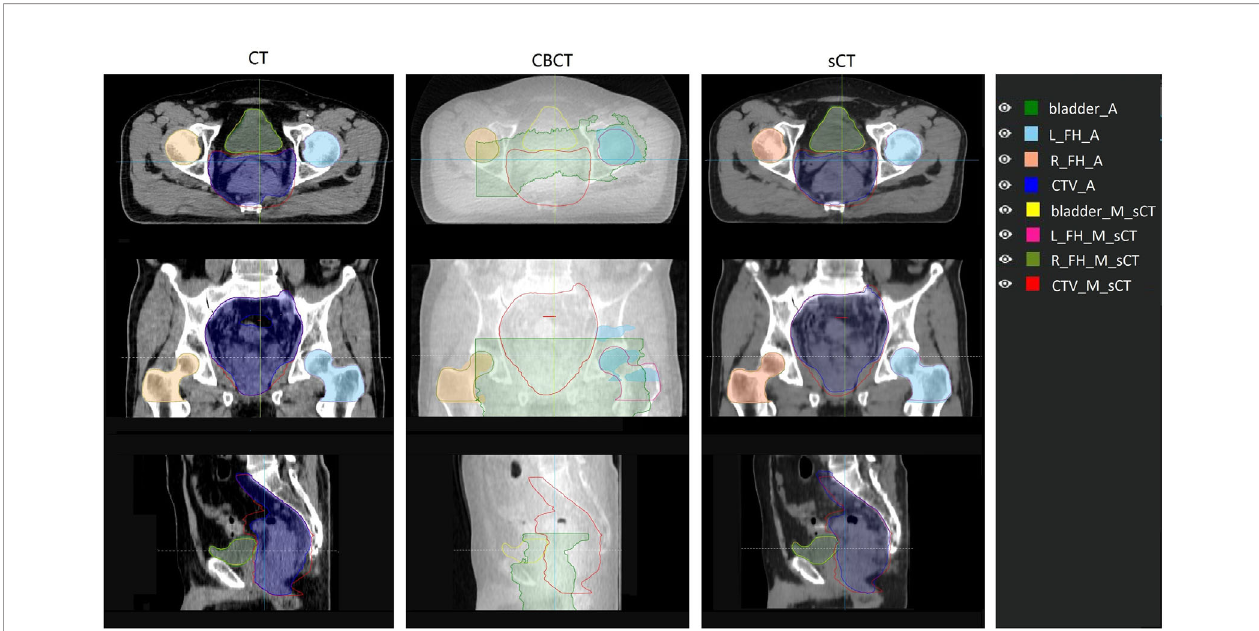
FIGURE 5 | Comparison of auto contour on different image set with the manual contour delineated on sCT. The manual contour was delineated on sCT and then copied to CT and CBCT. Contour name with “ _A ” suf fi x represents auto contour. Contour name with “ _M_sCT ” suf fi x represents contour manually delineated on sCT. L_FH and R_FH means left femoral head and right femoral head.